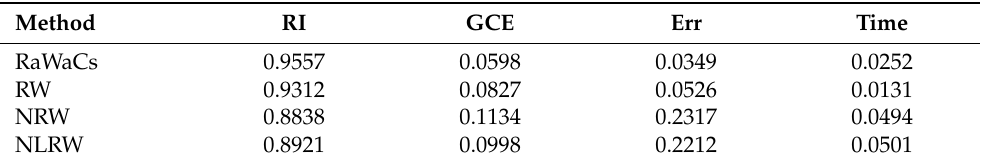
Table 1. Performance measures for RaWaCs , the random walk, the normalised random walk and the normalised lazy random walk methods. The former overcomes all the other methods. σ g is set to 90 and to 50 for NRW and for NLRW, respectively, while α = 0.6 for NLRW (see [27] for the details). The average computational time is measured in seconds.